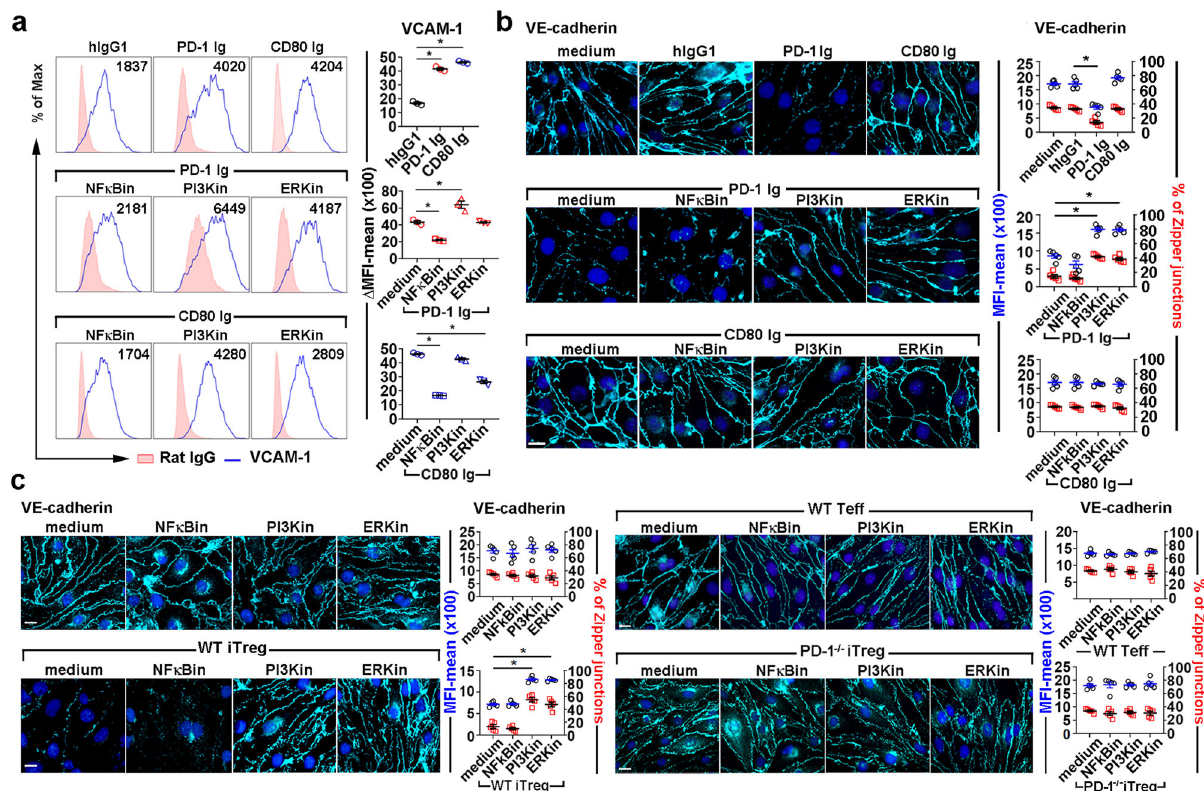
Fig. 4 PD-L1 signals through NF κ B-p65, ERK, and PI3K/Akt pathways to regulate endothelial structure. a – c LECs pretreated with classical NF κ B inhibitor (NF κ Bin, 5 μ M), PI3K inhibitor (PI3Kin, 0.5 μ M), or ERK inhibitor (ERKin, 5 μ M) for 30 min at 37 °C, then stimulated with soluble 1 μ g/mL PD-1 Ig, CD80 Ig, or incubated with 2 × 10 5 WT or PD-1 − / − iTregs or WT Teffs for 16 hours at 37 °C. VCAM-1 surface expression analyzed by fl ow cytometry ( a ). Intercellular VE-Cadherin analyzed by immunohistochemistry ( b , c ). Quanti fi cation of zipper junctions in LECs. Each dot represents every 10 LECs. Magni fi cation ×60, scale bar 10 μ m ( b ) and 20 μ m ( c ). Data representative of 3 independent experiments. ( a – c ) Mean ± SEM. * p < 0.01 by one-way ANOVA with Sidak ’ s multiple comparisons test. Source data are provided as a Source Data fi (Fig. 6b right) migration to dLNs. Additionally, PD-1 − / − iTregs also showed impaired migration into the dLNs (Fig. 6c).